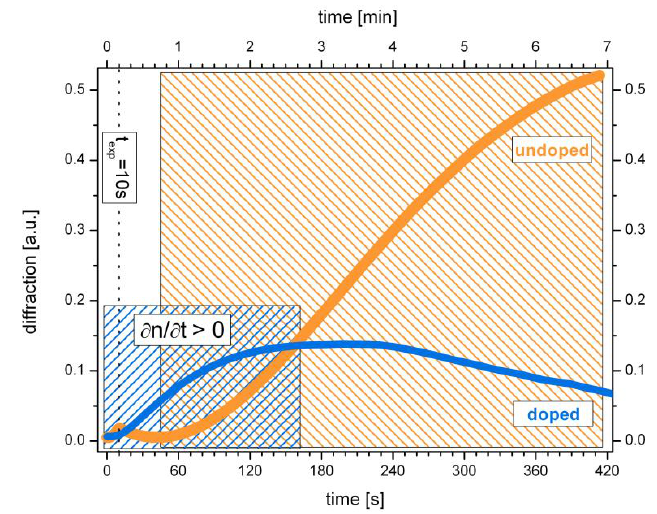
Figure 3. Direct comparison of the first growth step on a real time scale. Exposure duration was 10 s for both the undoped (orange) and doped system (blue), respectively. The shaded areas correspond to the time frames with positive change of the refractive index ( ∂ n / ∂ t > 0).